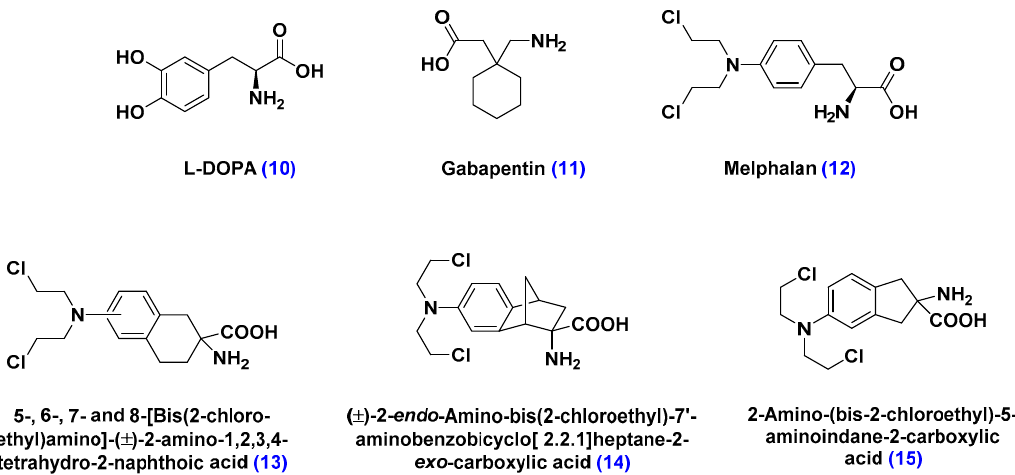
Figure 12. Structure of large amino acid substrates of large neutral amino acid transporters (LATs).